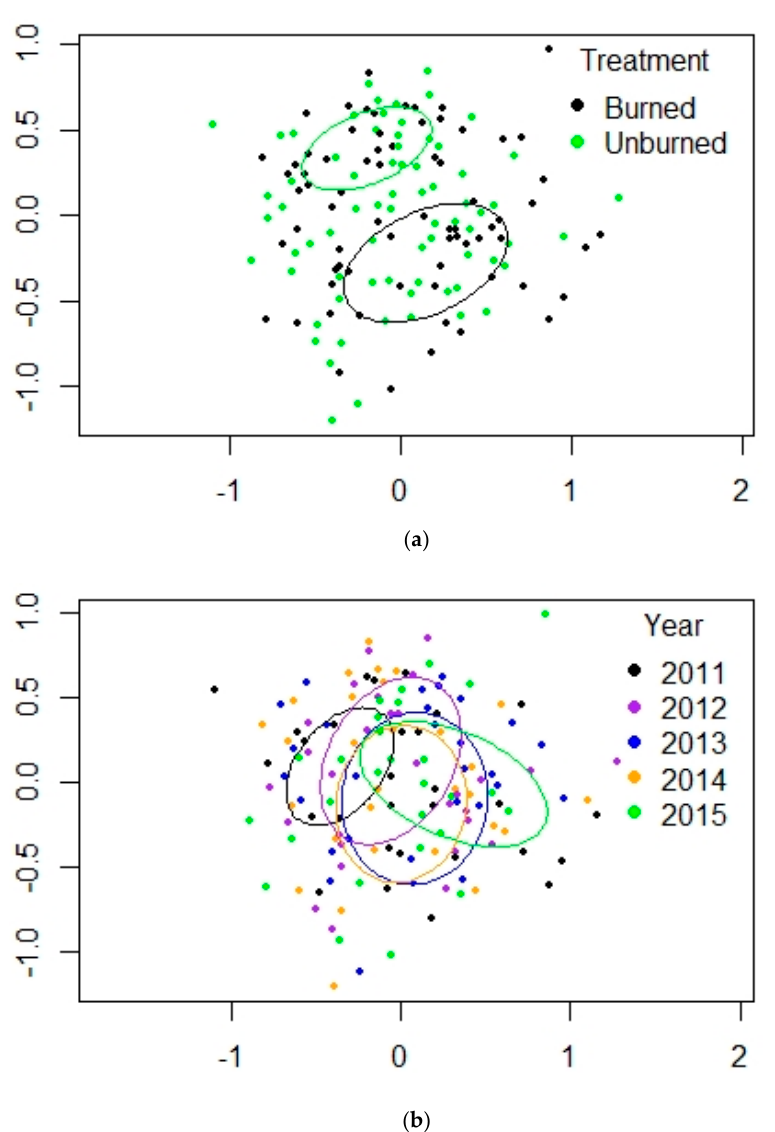
Figure 4. ( a , b ). NMDS plots for PERMANOVA results for ponderosa pine forest at Valles Caldera. ( a ) treatment, ( b ) year. Ellipses are the 95% confidence intervals for the locations of the centroids.